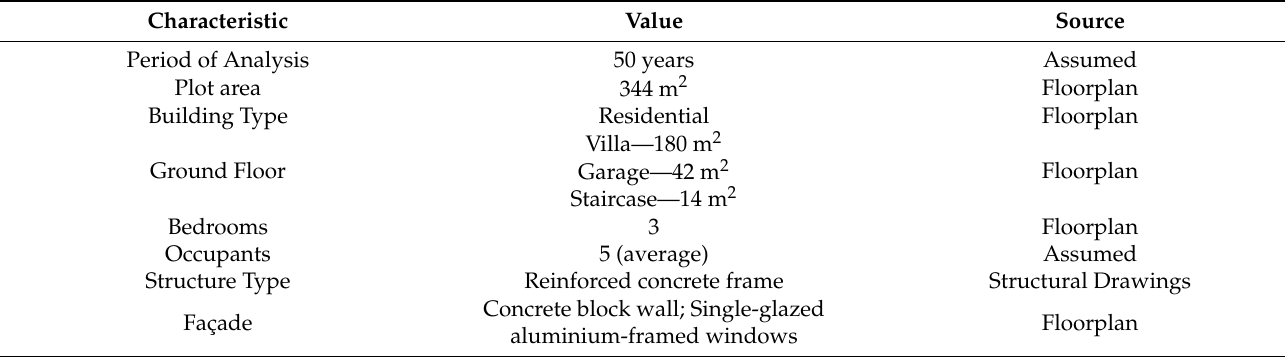
Figure 4. Case study house description. Table 3. Main characteristics of the case study